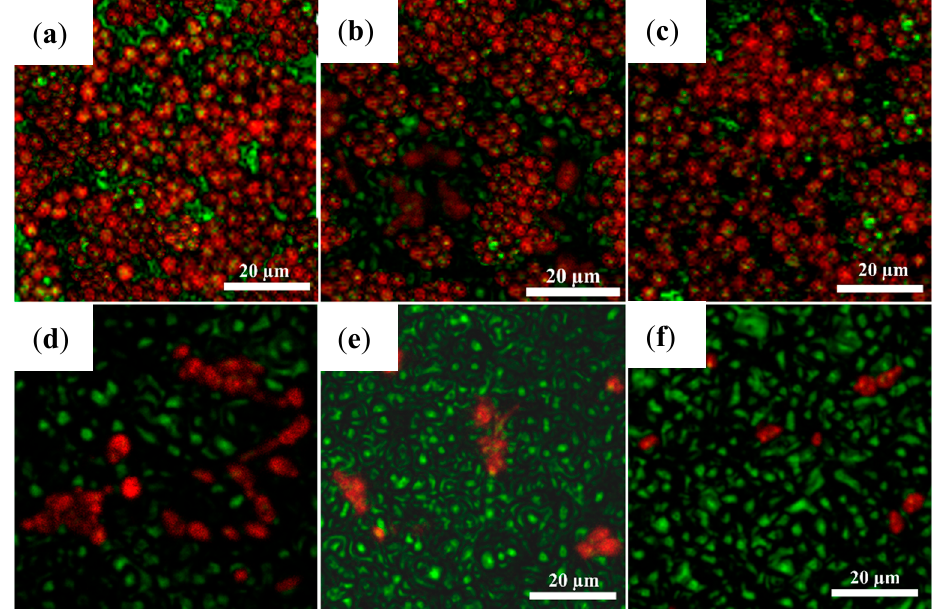
Figure 15. 2D confocal Laser Scanning Microscopy (CLSM) images of Candida albicans ATCC 10231 adhesion on HAp ( a – c ) and 5SmHAp ( d – f ) coatings deposited on Si after 24 h ( a , d ), 48 h ( b , e ) and 72 h ( c , f ) of incubation.